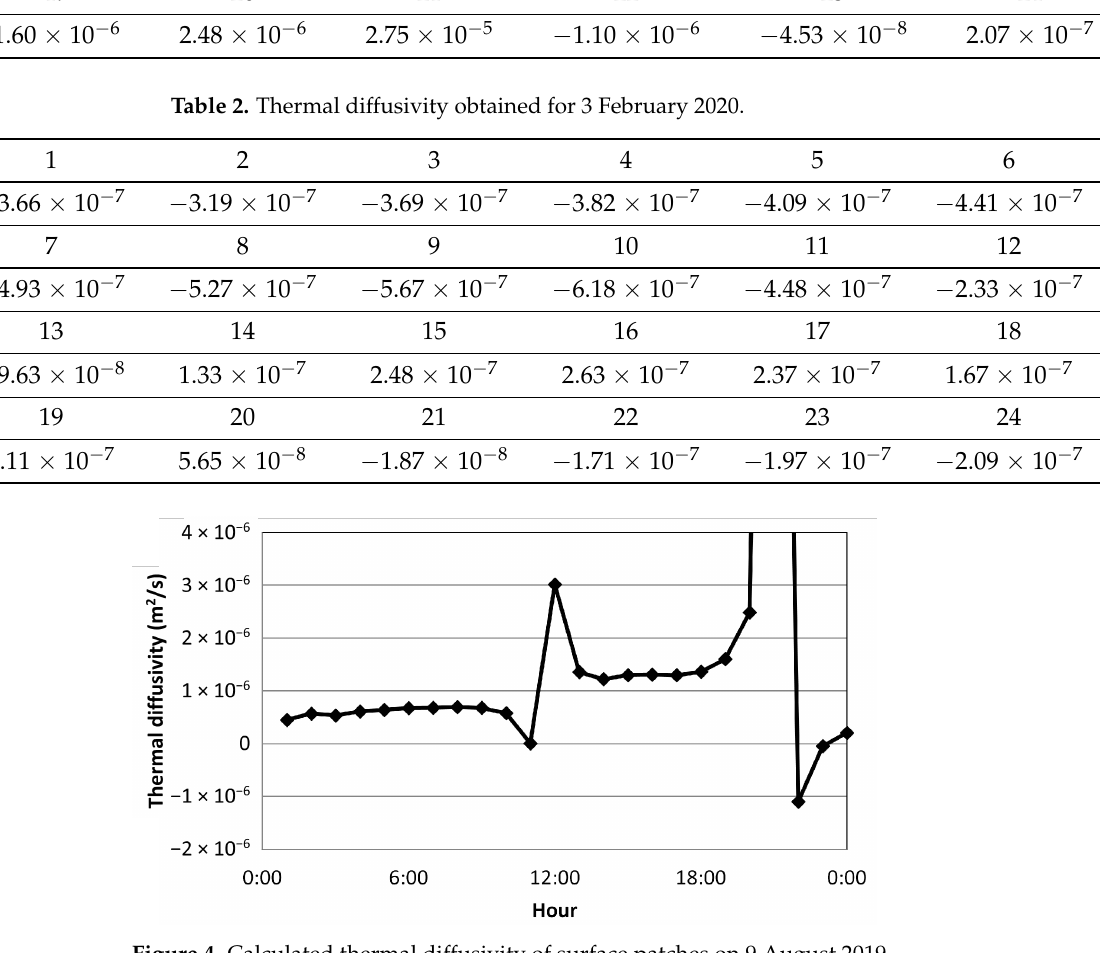
Figure 4. Calculated thermal diffusivity of surface patches on 9 August